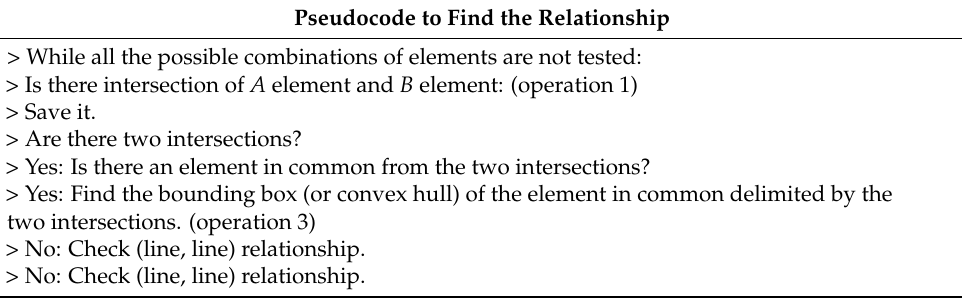
Table 2. The process to find traffic-related events with the relationship ( line , line , line ). Pseudocode to Find the